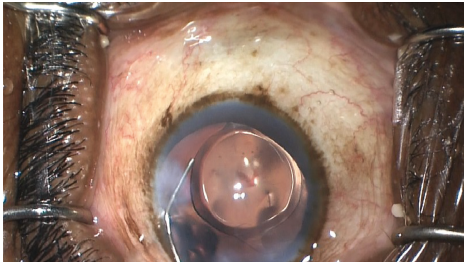
Figure 3: Blanching of aqueous veins with balanced saline solution through the Hydrus stent.